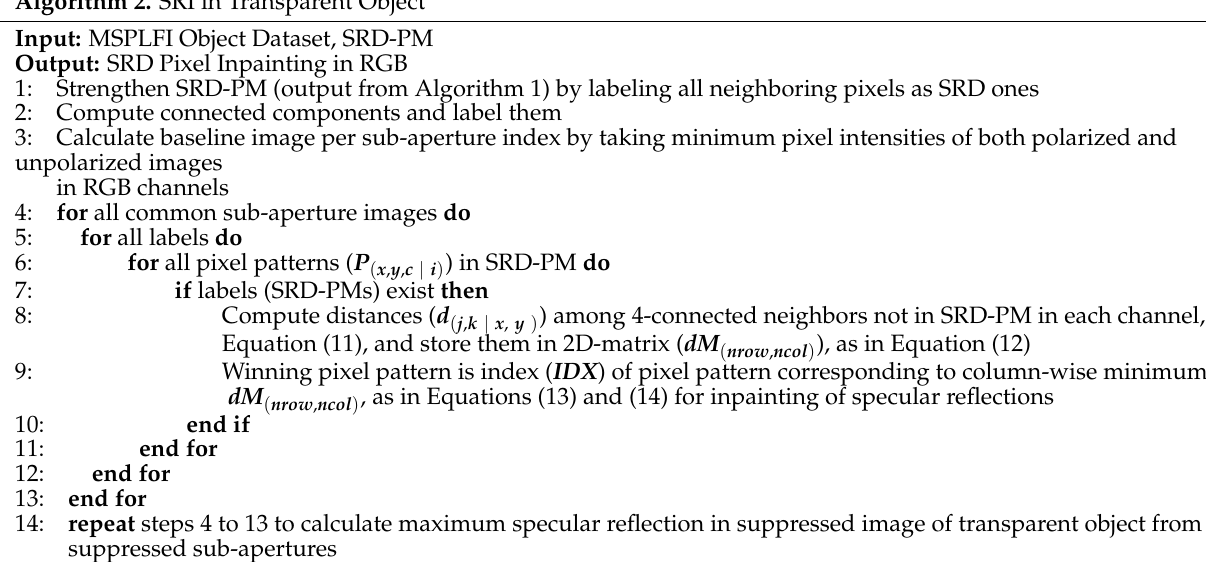
Algorithm 2. SRI in Transparent